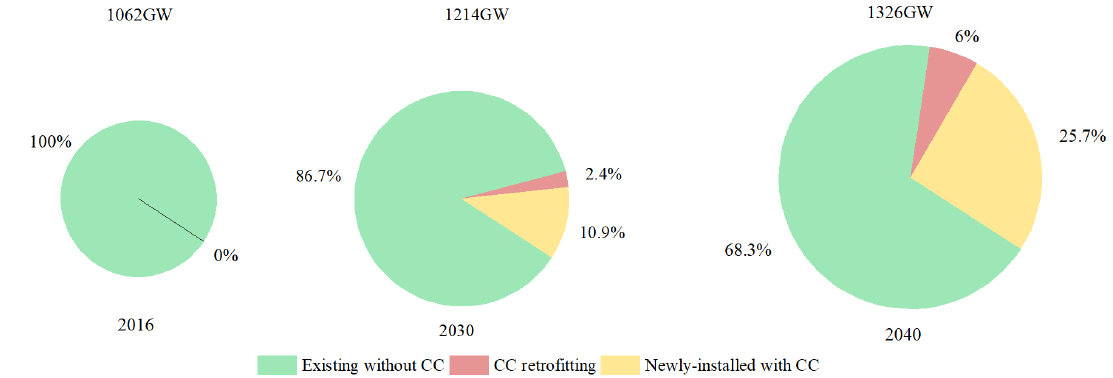
Figure 7. Cumulative Installed Capacity of Thermal Power by Technology Type.